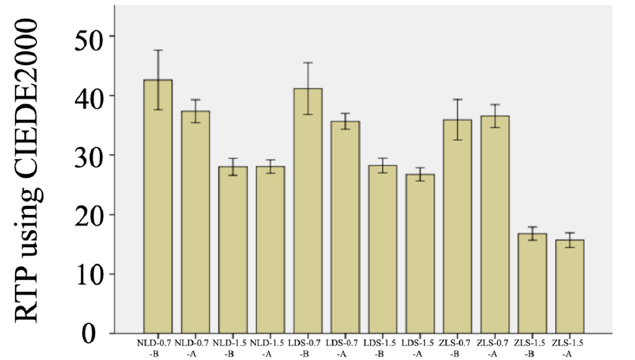
Figure 4. Mean RTP values and 95% confidence limits for each material–thickness pair: B, baseline; A, after coffee thermocycling.